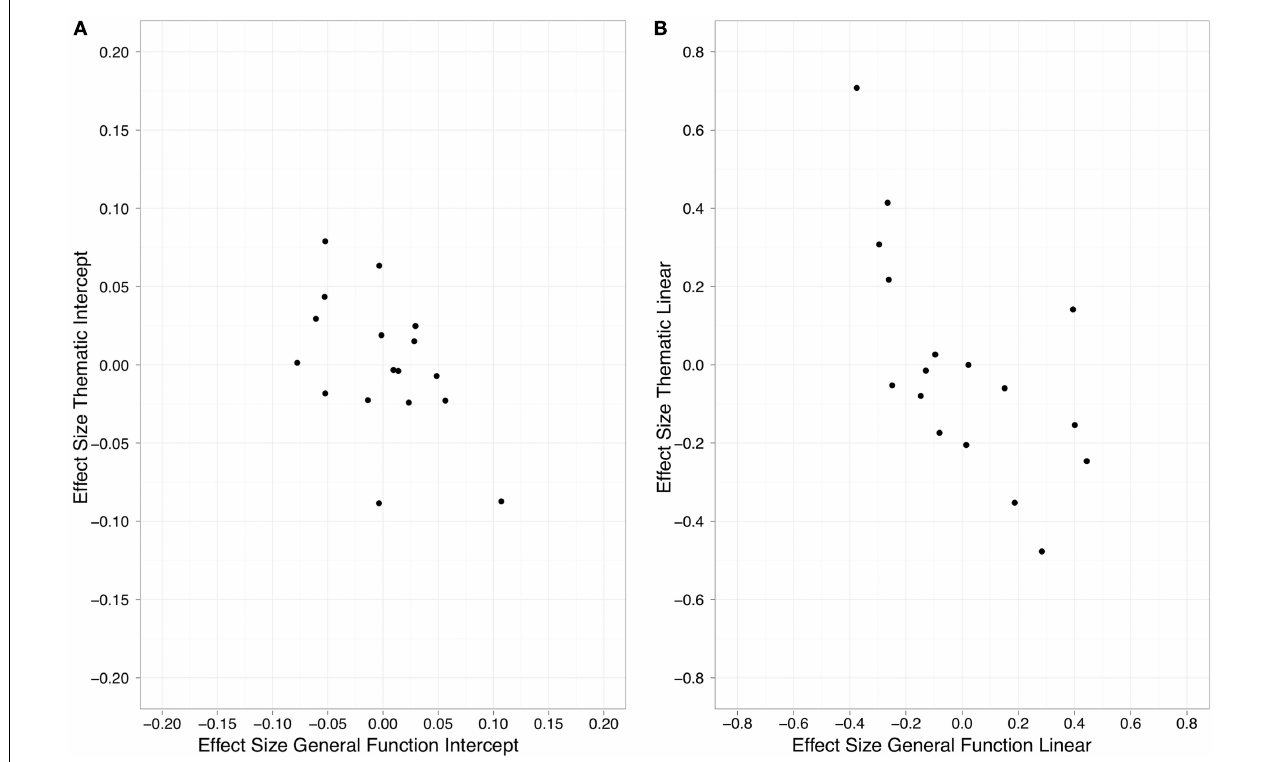
FIGURE 3 | Relationship between individual competition effect estimates in the thematic and general function displays on the intercept (A) and linear (B) terms of the model for the group of stroke